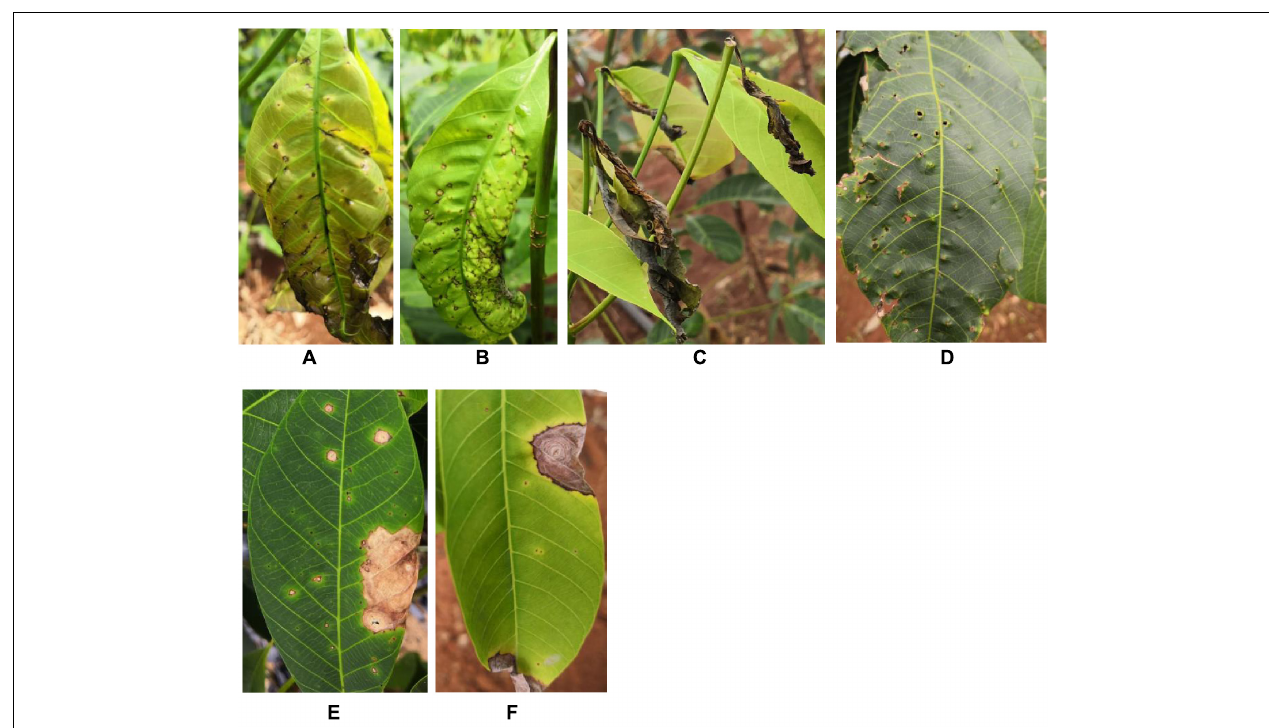
FIGURE 1 | Symptoms caused by Colletotrichum siamense and Colletotrichum australisinense on rubber trees in the field. (A,B,D) Raised or wrinkled spots caused by C. australisinense on the copper brown, light green, and mature leaves. (C) Die-back symptoms caused by C. australisinense on rubber tree leaves. (E,F) Anthracnose symptoms caused by C. siamense on mature rubber leaves.